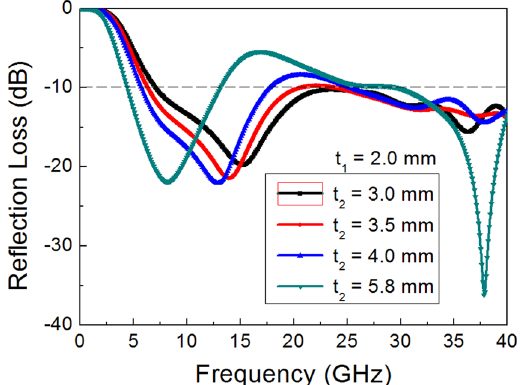
Figure 7. Simulation results of the reflection loss for the double layered absorbers with a patch/square loop (FSS1/FSS2) combination with reducing the second substrate thickness ( t 2 ) at a constant t 1 = 2.0 mm.